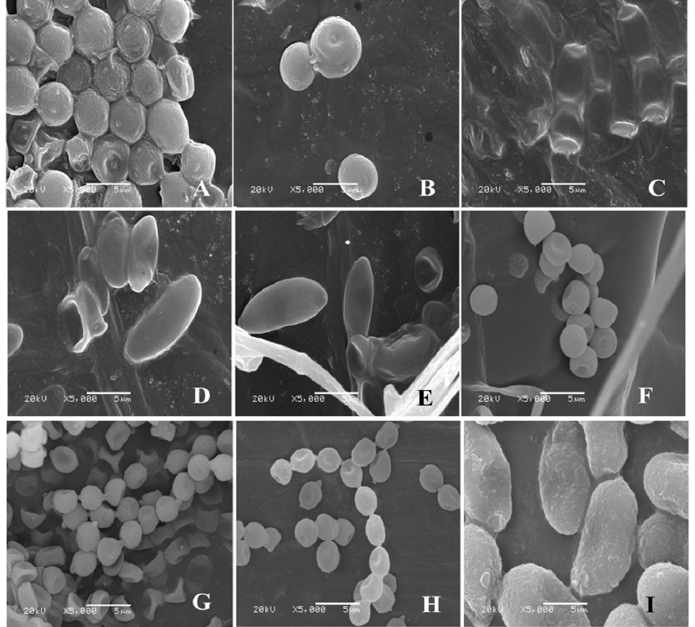
Figure 3. Morphology of conidium of isolates from fresh C. pilosula with postharvest disease during different storage stages. ( A ): Actinomucor elegans ; ( B ): Mucor hiemalis ; ( C ): Fusarium acuminatum ; ( D ): Fusarium equiseti ; ( E ): Fusarium oxysporum ; ( F ): Clonostachys rosea ; ( G ): Penicillium expansum ; ( H ): Penicillium aurantiogriseum ; ( I ): Trichothecium roseum .